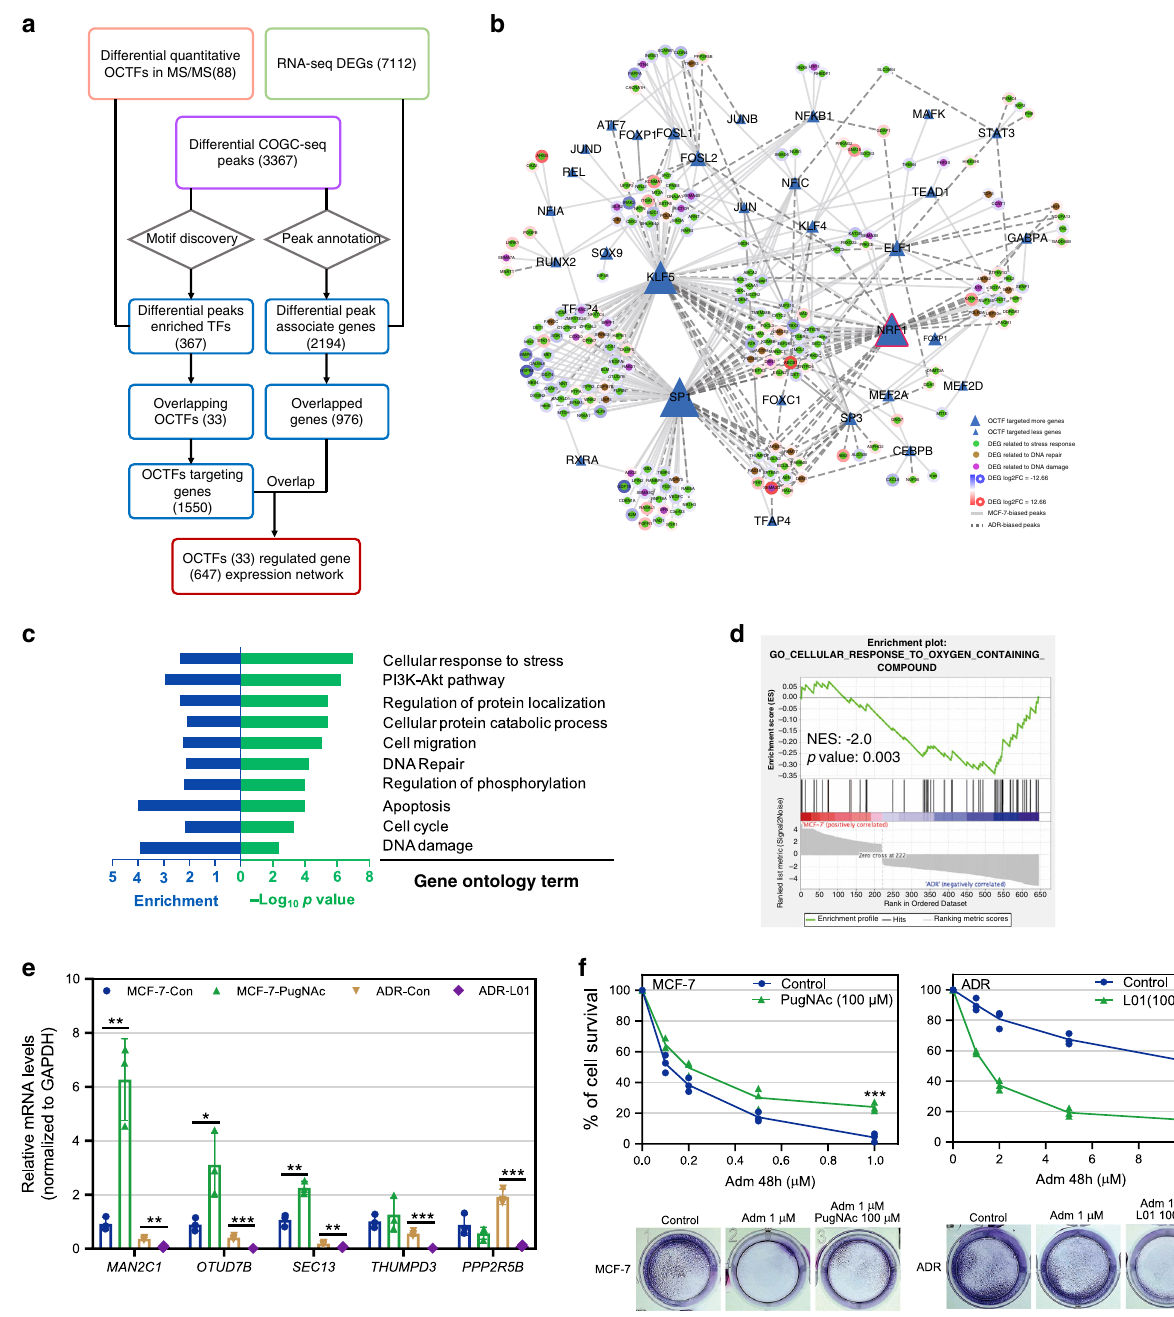
Fig. 5 OCTFs regulate genotoxic stress-responsive transcriptional reprogramming. a Schematic of an integrative omics analysis strategy for the discovery of an OCTF-regulated gene expression network during the genotoxic response. RNA-seq DEGs of MCF-7 and ADR cells were compared with COGC-seq differential peak-associated genes. The overlapping genes were subsequently linked to OCTF-targeting genes. The end result was 33 genotoxic stress-response OCTFs that directly regulate the expression of 647 genes to maintain cellular homeostasis. b Predicted regulatory network between genotoxic stress-responsive OCTFs (triangle nodes) and the corresponding downstream DEGs (round nodes) in MCF-7 and ADR cells. The solid and dashed lines represent regulatory relationships from OCTFs to target genes in MCF-7 and ADR cells, respectively. Highly connected OCTFs are indicated with a large size. For the round nodes, different round fi ll colors represent the supposed function of the DEGs and the different border colors represent the expression level of DEGs (red, high; blue, low). c GO terms enriched for 647 OCTFs targeting genes in the network. d GSEA of OCTF-targeting genes in the network revealing enrichment in pathways related to the stress response. The NES and p value are indicated. e Effect of 100 μ M PugNAc or L01 (24 h) on the indicated gene mRNA levels in MCF-7 and ADR cells. Con, control (vehicle). The data are presented as means ± SEM. f MCF-7 and ADR cells were treated with increasing doses of Adm alone (control, Con) or together with 100 μ M L01 (or PugNAc) for 48 h, and the cell viability was assessed using CCK8 assay. Replicates are represented. Representative images of cell viability determined by crystal violet staining are shown. The staining results were reproduced in two biologically independent experiments. For ( e ) and ( f ), n = 3 biologically independent experiments. * p < 0.05, ** p < 0.01, *** p < 0.001 (two-sided unpaired Student ’ s t -test). p values: 0.003794, 0.001189, 0.033775, 0.000744, 0.003298, 0.005793, 0.000656, 0.00039 ( e ); 0.000991, 0.000021 ( f ). Experiments were repeated independently two times ( e ) and ( f ) with similar results. c , e – f Source Data are provided as a Source Data fi